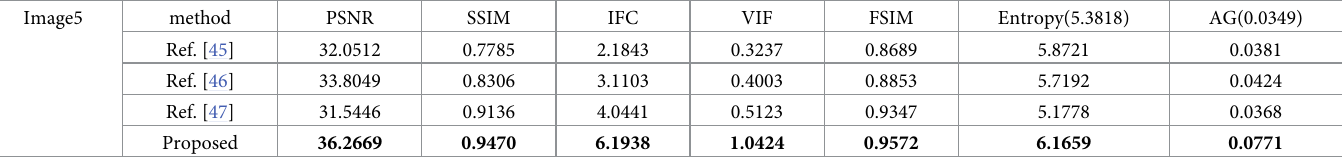
Table 11. The performance evaluation of various image contrast enhancement approaches using test images 5.